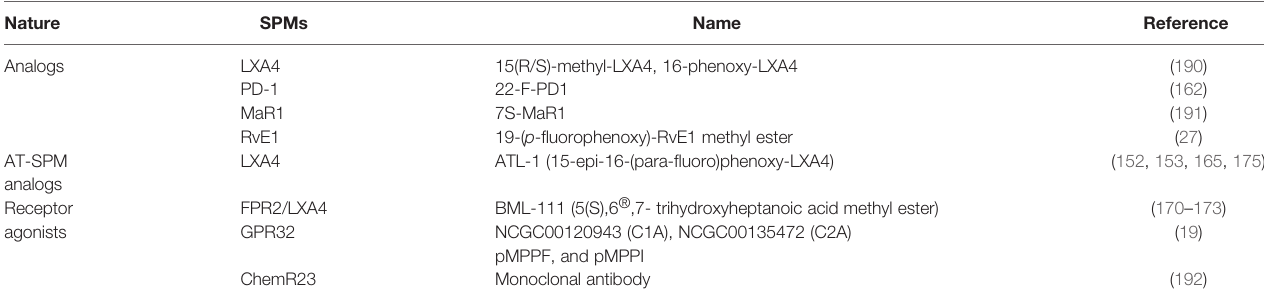
TABLE 4 | SPMs or AT-SPM analogs and receptor agonists.